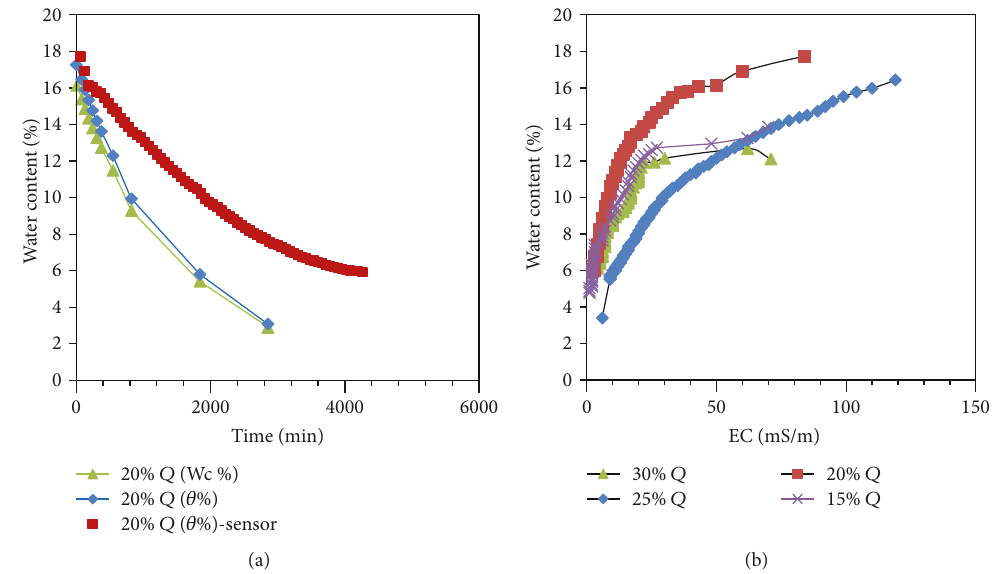
Figure 3: (a) Moisture measurements for 20% clay mixture. (b) Electrical conductivity measurements for four di ff erent clay mixtures.